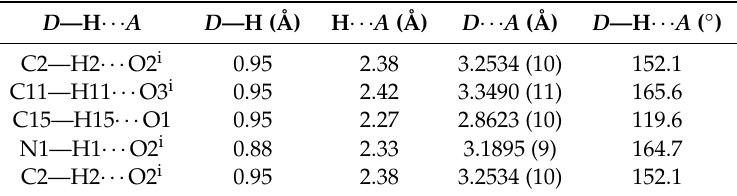
Table 2. Selected hydrogen-bond parameters (Å, ◦